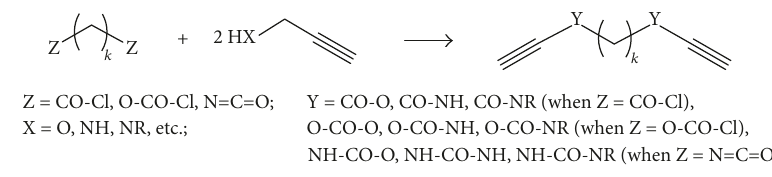
Figure 1: The synthesis of diyne monomers.